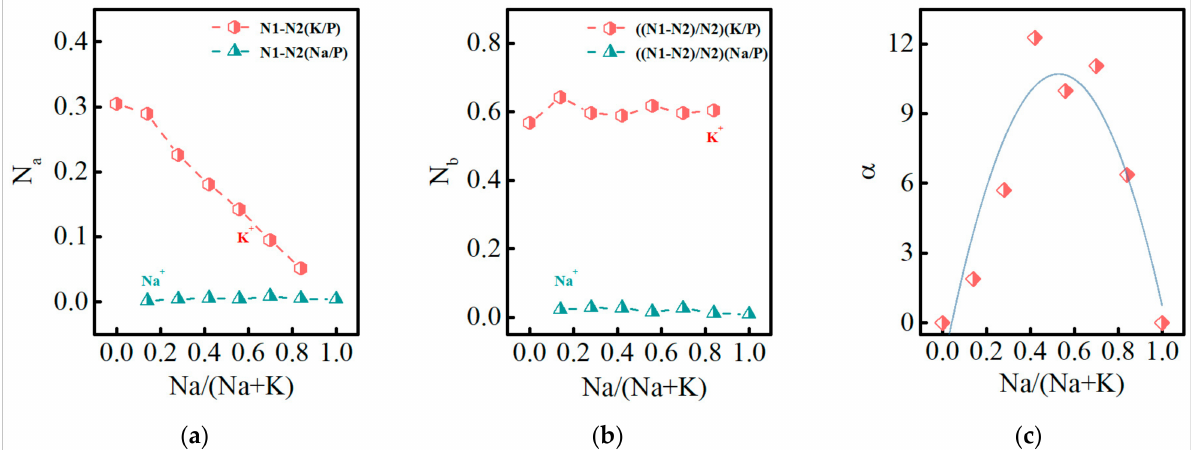
Figure 5. ( a ) N a of PKNi glass with different Na/(Na+K) ratios (the empirical index of ion exchange overflow); ( b ) N b (ratio of ion exchange and mesh dissolution); ( c ) mixed alkali affect value α